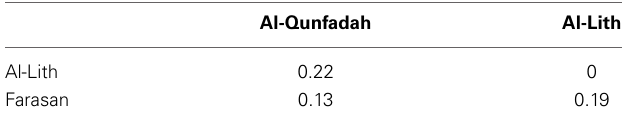
Table 5 | Weighted Unifrac matrix between the 3 reefs for the 1389F primer.